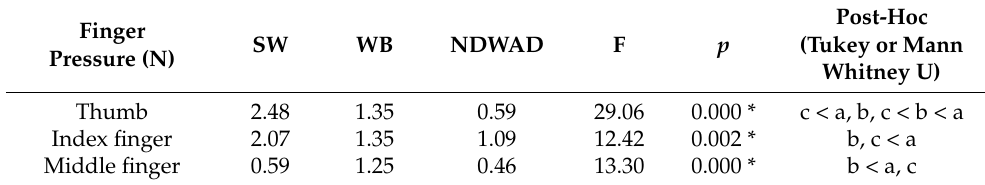
Table 6. Finger pressure associated with the use of each WAD.